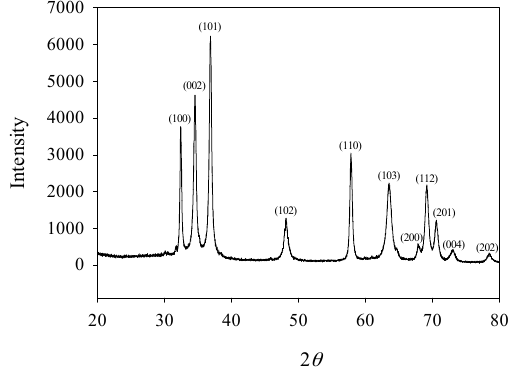
Figure 1. X-ray diffraction pattern of a polarized GaN sample.